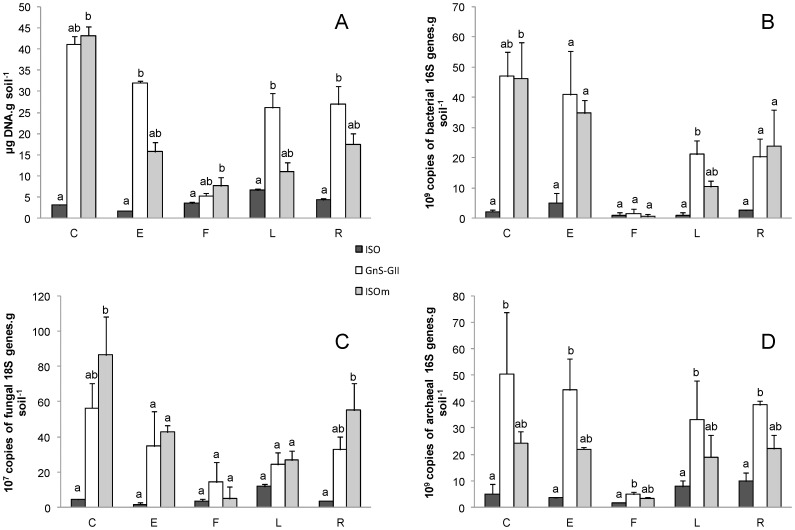
Quantifications of crude extracted DNA and microbial abundances according to extraction procedures in different soils.Quantification of (A) crude extracted DNA, (B) 16S rRNA genes, (C) 18S rRNA genes, (D) archaeal 16S rRNA genes according to three different extraction procedures (ISO, GnS-GII and ISOm) in five different soils (C, E, F, L, R). Bars correspond to averages of three replicates ± SD (n = 3). Within each soil, bars topped by the same letter are not significantly different at p<0.05.